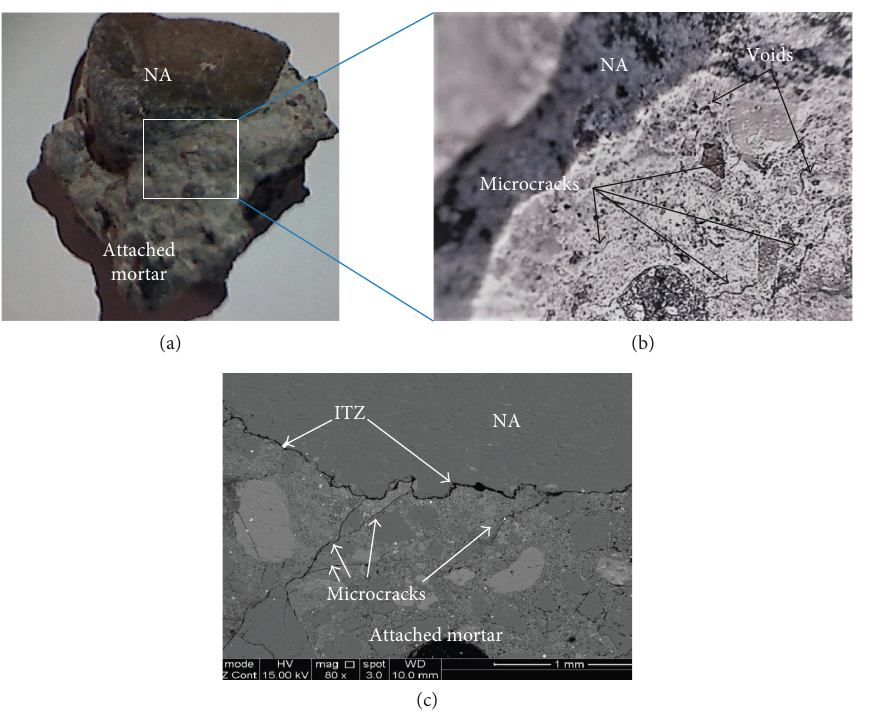
Figure 9: (a) RA particle at 20x magnification. (b) RA surface at 200x magnification. (c) SEM image of the surface of a recycled coarse aggregate particle.